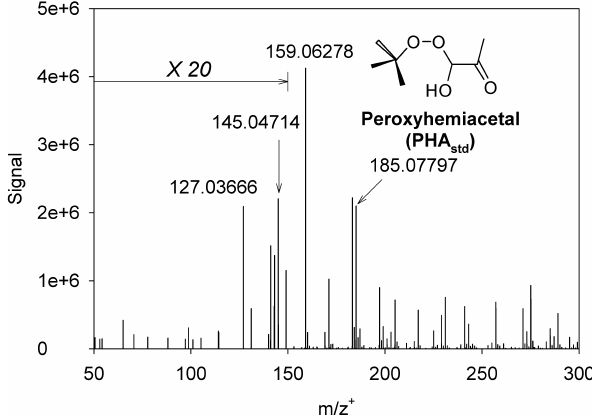
Figure 4. FTICR-MS/MS for m/z + 159